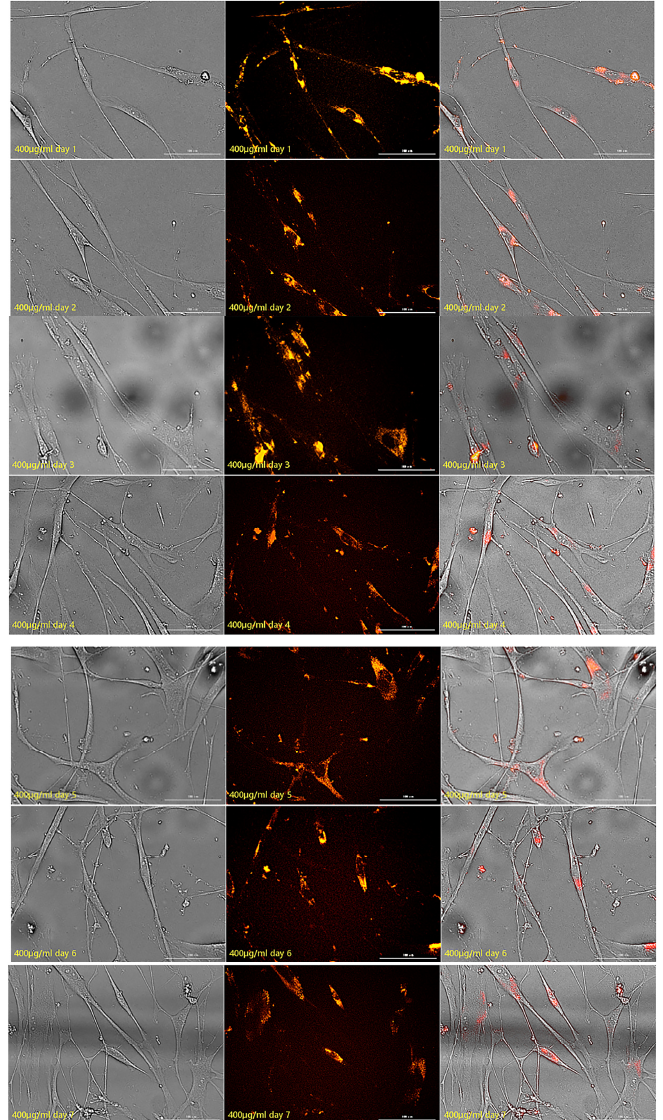
Figure 12. The fluorescence map from the first day to the seventh day, about 400 μ g/mL AGQDs-labeled HSFs. From left to right, there are bright field, fluorescent field and composite picture, respectively. Scale bars: 100 μ m.